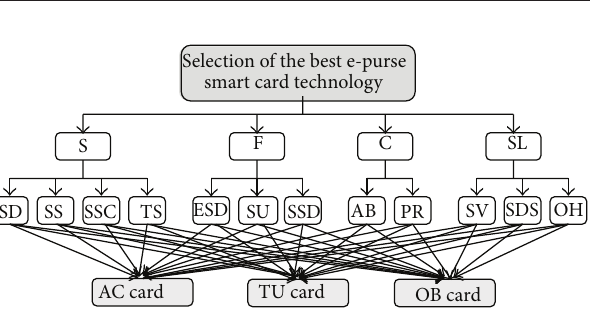
Figure 6: The hierarchy for selection of e-purse card technology problem.